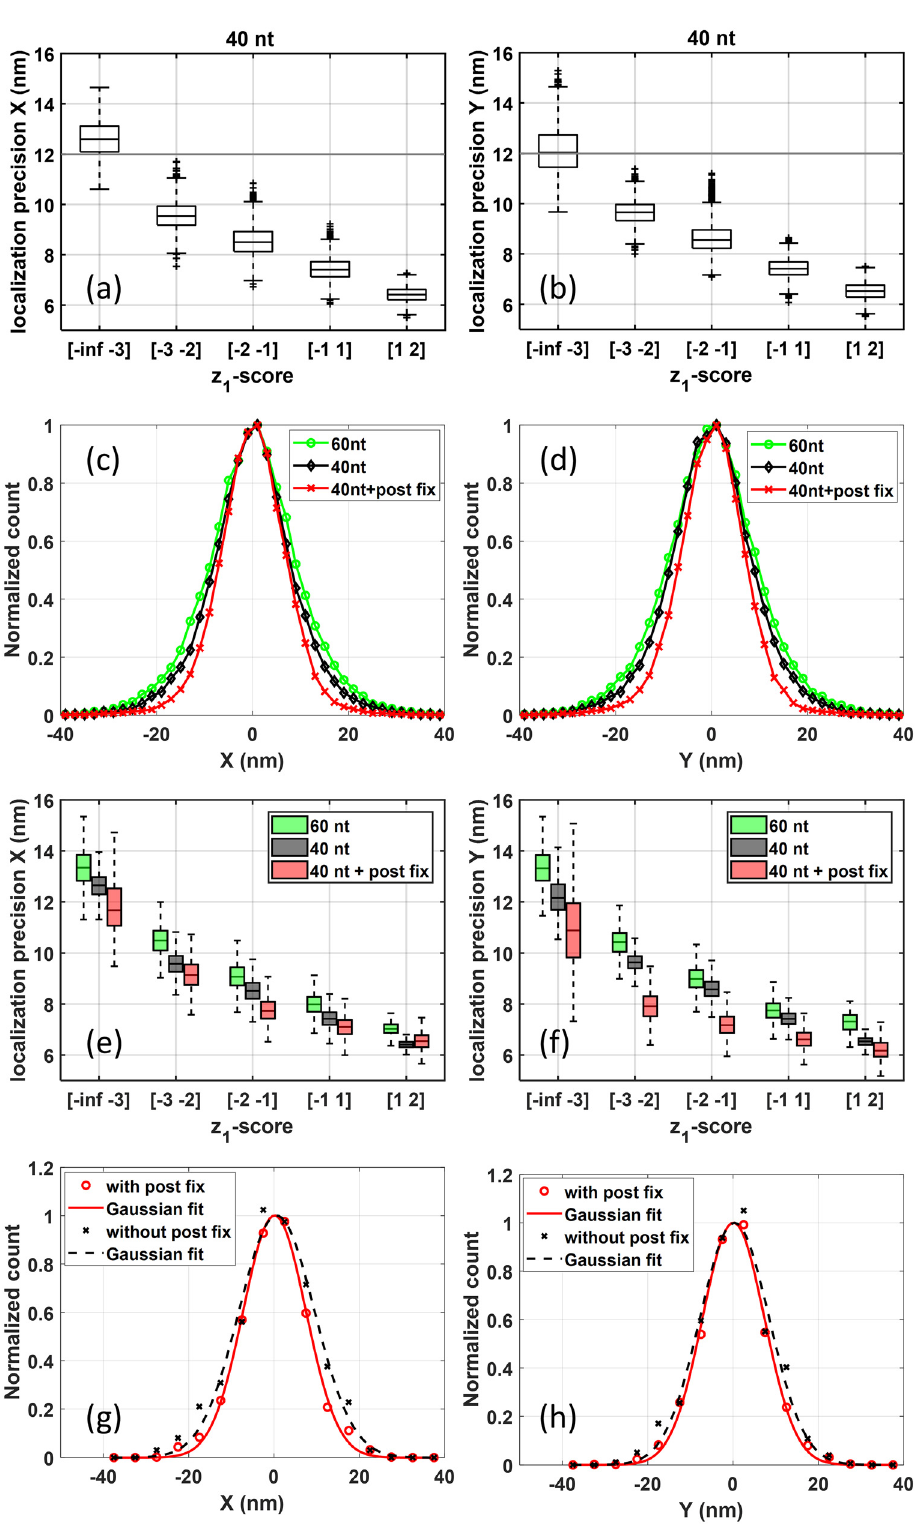
Figure 4: Localization precision in x-direction (left panel)and y-direction(right panel) are affectedby the stochastic motion of bio-molecules. (a) and (b) Boxplot of localization precision distribution calculated from molecules with different z 1 -scores. Within each box, horizontal black lines denote median values; boxes extend from the 25th to the 75th percentile of each group ’ s distribution of values; vertical extending lines denote adjacent values (i.e., the most extreme values within 1.5 interquartile range of the 25th and 75th percentile of each group); (c) and